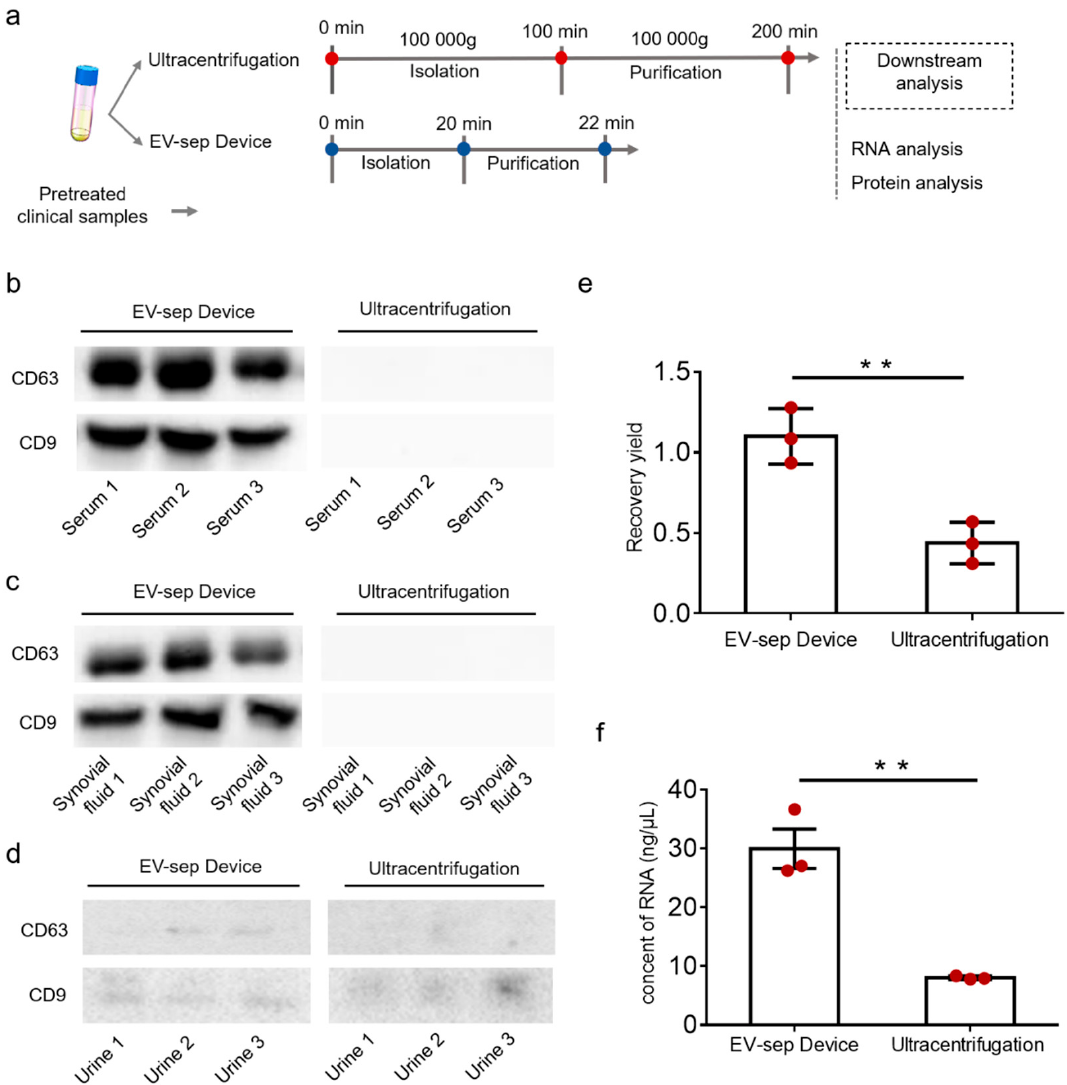
Figure 5. Comparison of exosome isolation in the EV-sep device and ultracentrifugation. ( a ) Workflow of the exosome isolation process of EV-sep device and ultracentrifugation. ( b ) Expression of exosome markers (CD9 and CD63) in serum exosomes isolated by EV-sep device and ultracentrifugation. ( c ) Expression of exosome markers (CD9 and CD63) in synovial fluid exosomes isolated by EV-sep device and ultracentrifugation. ( d ) Expression of exosome makers (CD9 and CD63) in urine exosomes isolated by EV-sep device and ultracentrifugation. ( e ) The recovery ratio of total RNA in serum exosomes isolated by EV-sep device and ultracentrifugation. The results were normalized to pretreated serum. ( f ) The concentration of total RNA in urine exosomes isolated by EV-sep device and ultracentrifugation. All experiments were performed in triplicate and the data were shown as mean ± S.D. ** p < 0.005 by two-sided paired Student’s t test.